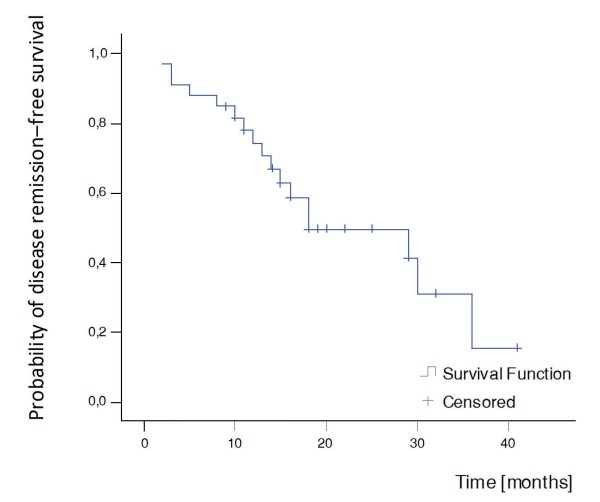
Kaplan-Meier curve for disease remission. Median survival time = 18 months.